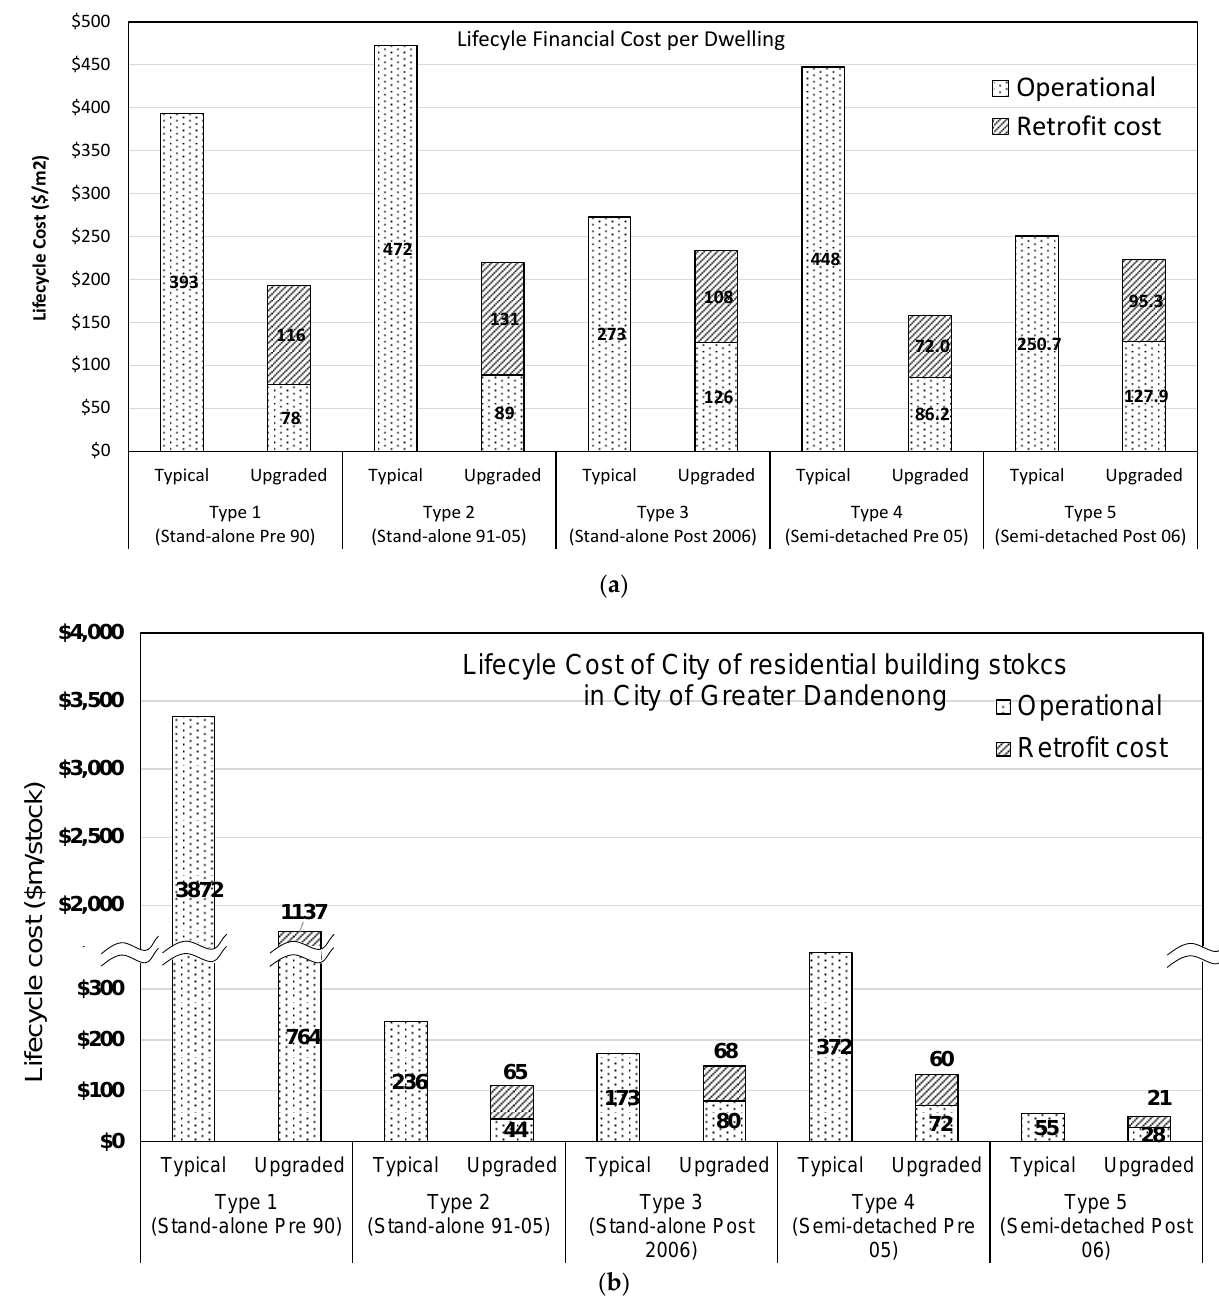
Figure 5. Lifecycle costs of dwelling types with different age brackets (AUD$). ( a ) Lifecycle cost of each prototype (AUD$/m 2 ); ( b ) Lifecycle cost of the whole stocks in the City of Greater Dandenong.